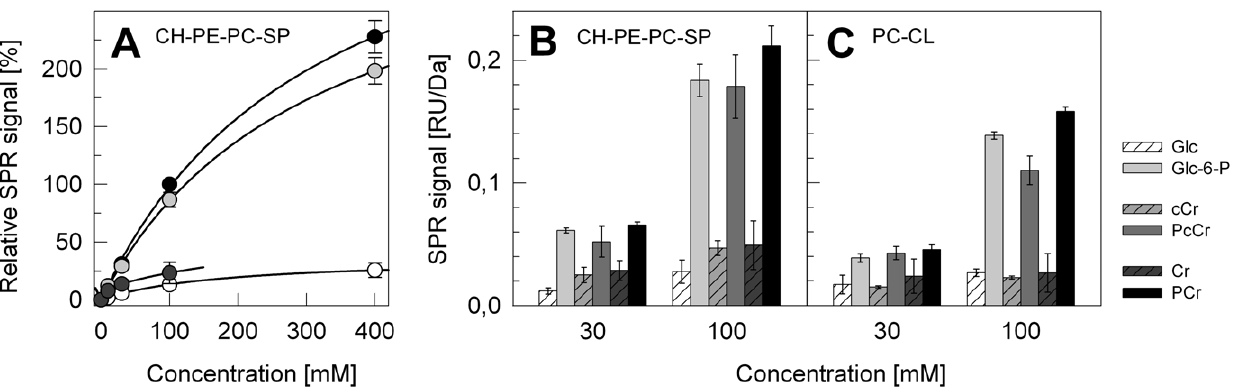
Figure 2. Direct interaction of phosphocreatine, creatine, their cyclic analogues, glucose and glucose phosphate with liposomes as determined by surface plasmon resonance. (A) Concentration-dependence of glucose (Glc, white), Cr (dark grey), glucose-6-phosphate (Glc-6-P, light grey), and PCr (black) binding to LUVs consisting of cholesterol, phosphatidylethanolamine, phosphatidylcholine, and sphingomyelin (CH/PE/ PC/SP). (B, C) Binding of PCr, Cr, their cyclic analogues, as well as glucose and Glc-6-P to LUVs consisting of either (B) CH/PE/PC/SP or (C) PC/CL. Runs were performed in TES buffer (10 mM pH 7.0, 50 mM NaCl). Bound metabolites were quantified at a reporting point 60 s after beginning of dissociation. The given SPR signal corresponds to measured response units (RU) divided by the molecular mass (Da) of the corresponding metabolite.